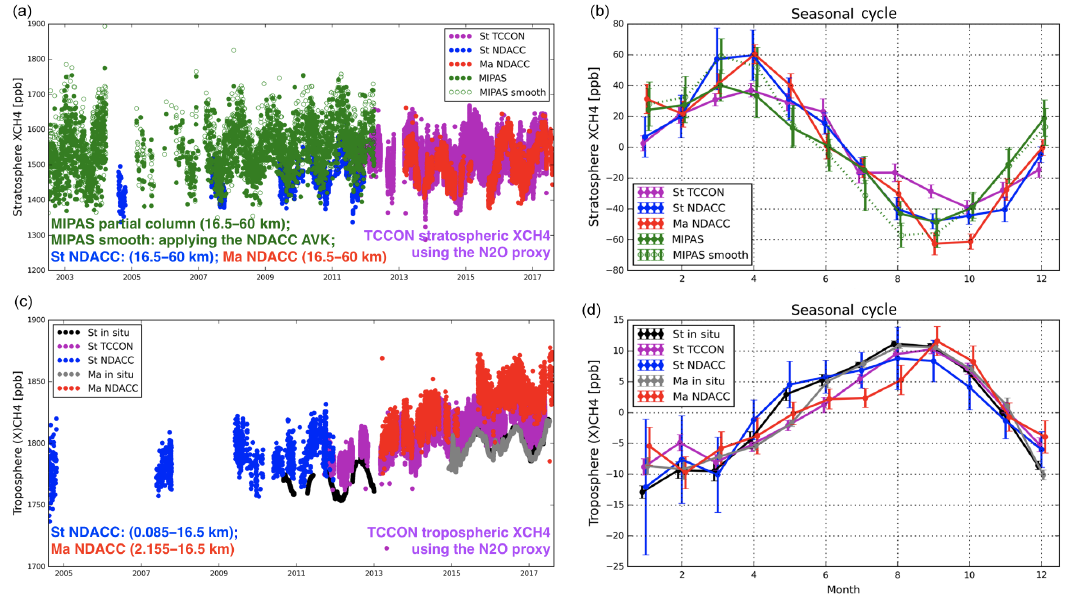
Figure 11. The time series and seasonal cycles of CH 4 from the in situ, FTIR (NDACC and TCCON) and colocated MIPAS measurements. (a) The time series of the stratospheric X CH from the TCCON retrievals (the N 2 O proxy method) at St Denis, NDACC and collocated 4 MIPAS partial columns (16.5–60km), and the smoothed MIPAS measurements using the St Denis NDACC AVK. (b) The seasonal cycles of all the data in the stratosphere. (c) The time series of the tropospheric ( X )CH 4 from the in situ measurements at St Denis and Maïdo, NDACC retrievals at St Denis (0.085–16.5km) and Maïdo (2.155–16.5km), and TCCON retrievals (the N 2 O proxy method) at St Denis. (d) The seasonal cycles of the available data in the